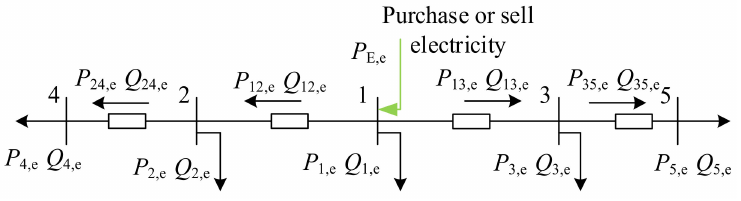
Figure 4. Electrical power network topology with energy